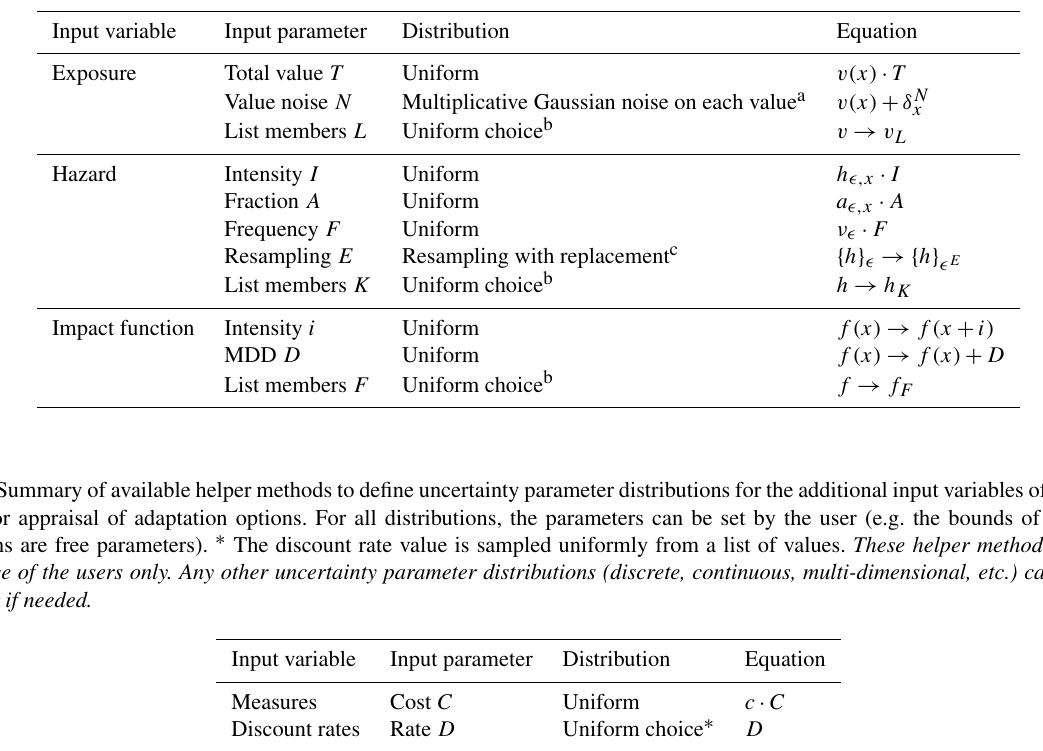
Table B1. Summary of available helper methods to define uncertainty parameter distributions for the main input variables of CLIMADA for risk assessment. For all distributions, the parameters can be set by the user (e.g. the mean and variance of a Gaussian distribution are free parameters). a The additive noise terms δ N x are all independently and identically sampled from the same truncated Gaussian distribution. The input parameter N labels the noise realizations (one realization consists of one value δ x for all locations x ). b The user can define a list of exposures, hazards, or impact functions to uniformly choose from. For instance, a list of exposures with different resolutions, or a series of LitPop exposures with different exponents can be used as shown in Fig. D1. Another example would be to define a pre-computed list of hazards obtained from a dynamical model (e.g. a flood model) for different dynamical model input factors, or use a list of hazards obtained from different data sources. Analogously, a list of impact functions obtained, e.g. with different calibration methods, could be used. c Events are sampled with uniform probability and with replacement. The size of the resampled subsets is a free parameter. For instance, size equal to 1 would correspond to considering single events, and size equal to the total number of events would correspond to bootstrapping. The input parameter E labels one set of resampled events. These helper methods are for the convenience of the users only. Any other uncertainty parameter distributions (discrete, continuous, multi-dimensional, etc.) can be defined by the user if needed.